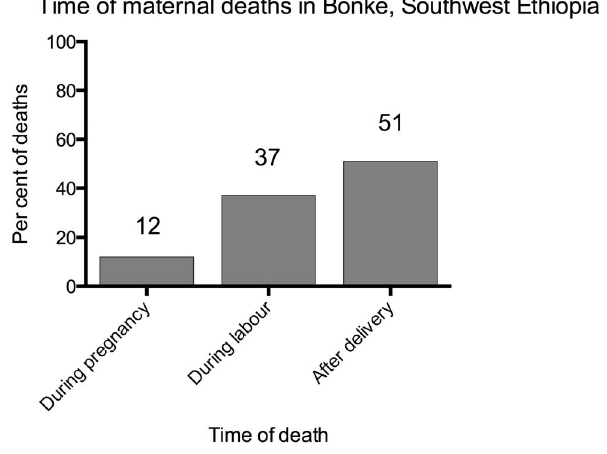
Figure 2. Time in weeks of neonatal deaths, Bonke woreda, south-west Ethiopia,